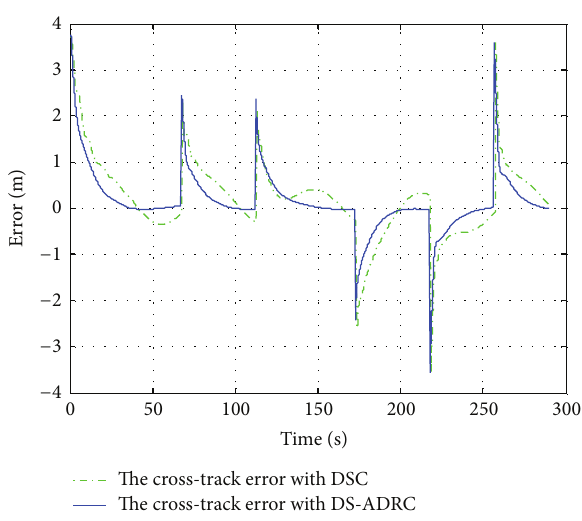
Figure 9: The cross-track error.